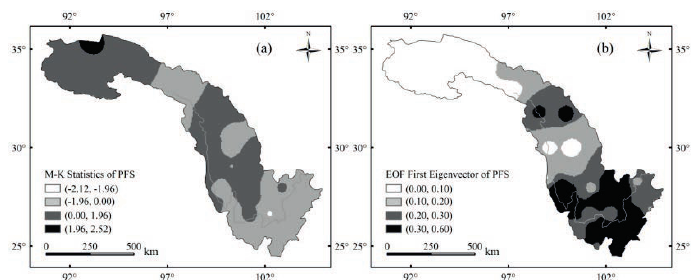
Fig. 5 Spatial changes of PFS during 1961–2010 in the Jinsha River basin: (a) M-K statistics, (b) EOF.